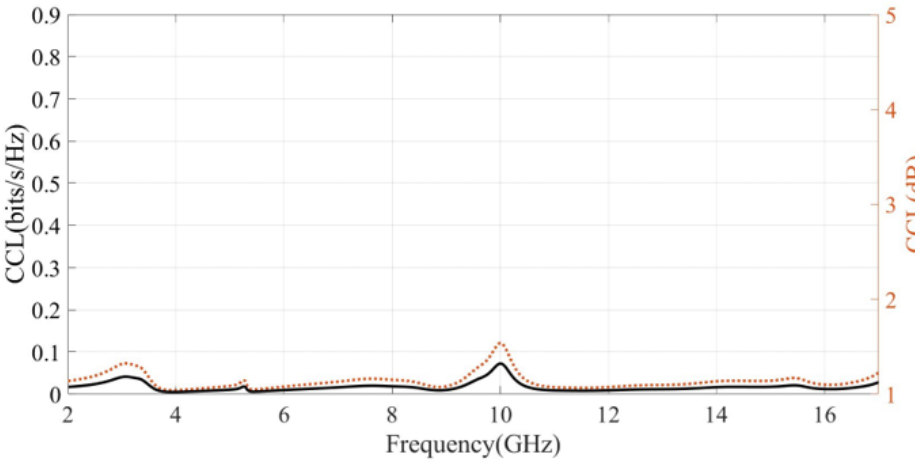
Figure 12. Channel coefficient loss (CCL) of proposed MIMO